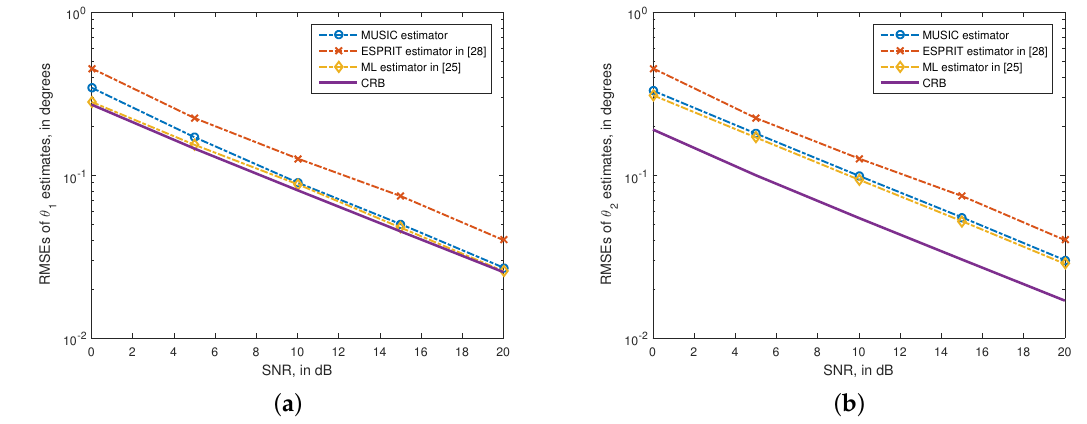
Figure 3. RMSEs of θ 1 and θ 2 estimates versus SNR. ( a ) θ 1 = 10 ◦ ; ( b ) θ 2 = 20 ◦ , ρ 2 = 0.5. N = 200. 500 independent trials.